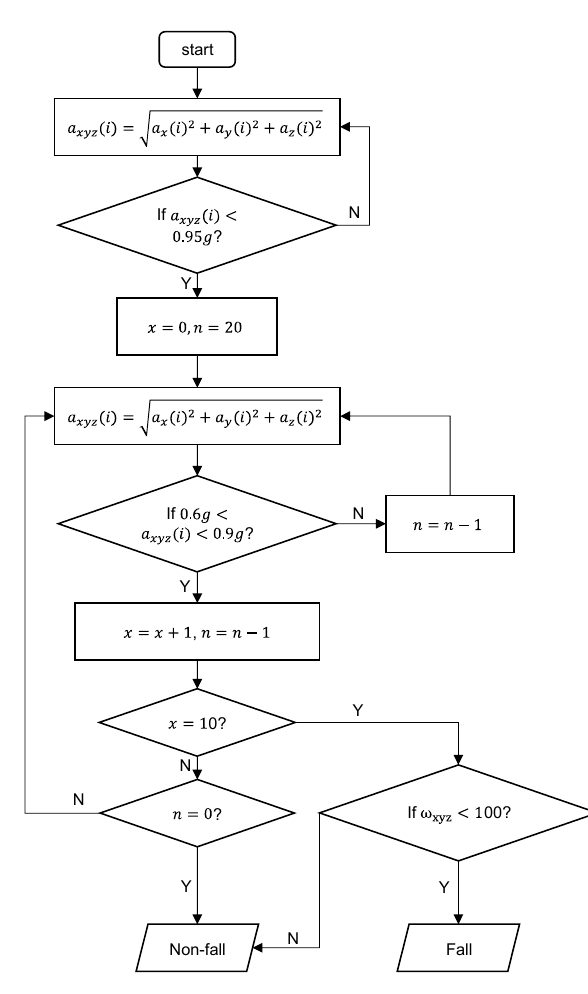
Figure 7. The threshold-based algorithm flow chart.